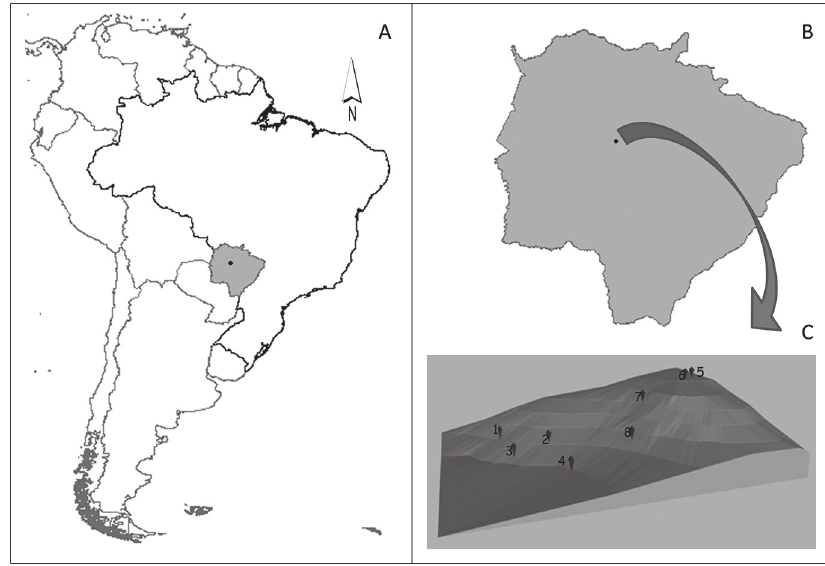
Figure 1 - Slope studied in the Serra de Maracaju (C) , Jaraguari (black point) (B) , South America (white), Mato Grosso do Sul, Brazil (gray) (A) . (in Figure C, 1,2,3,4,5,6,7,8 identify the